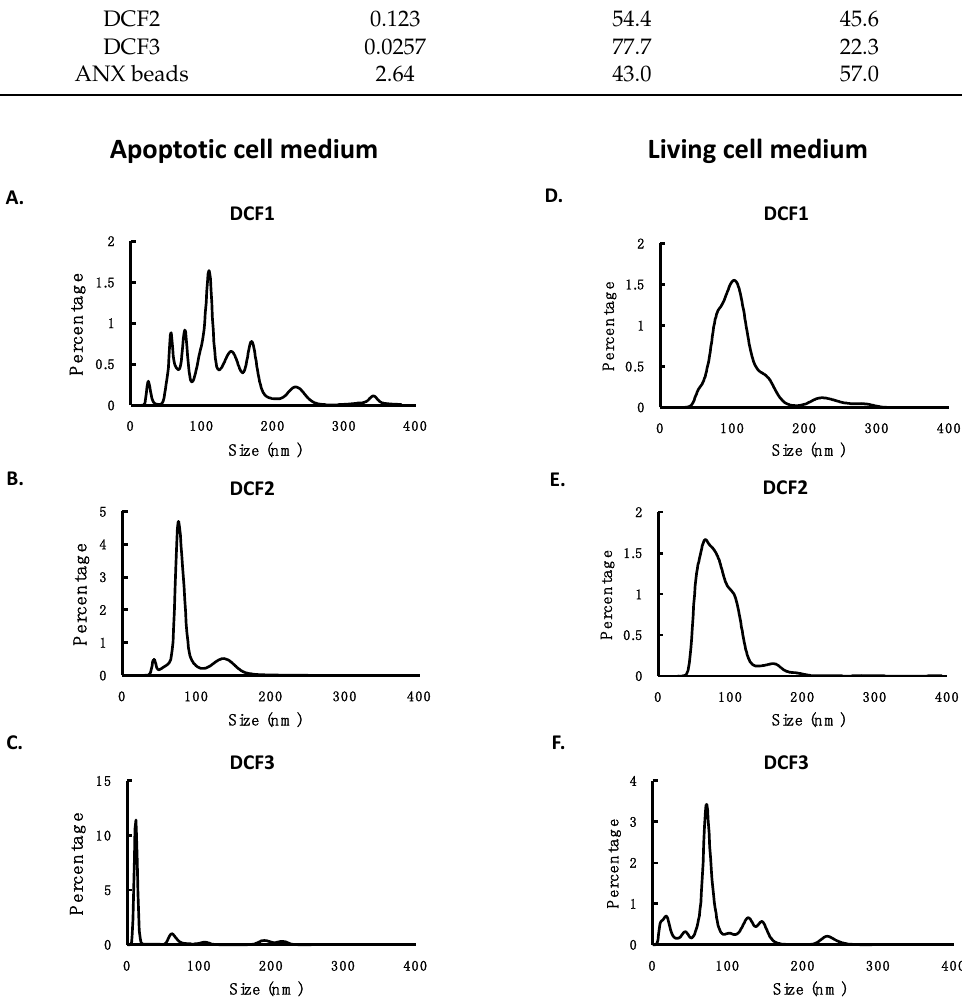
Figure 1. The particle size profiles of different differential centrifugation fractions of EVs from the medium with apoptotic cells ( A – C ) and that with living cells ( D – F ). DCF1, DCF2, and DCF3 were three fractions of the media derived from two-step centrifugation, as described in Materials and